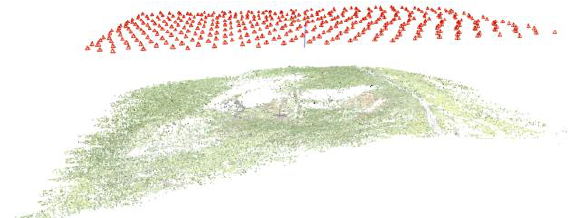
Figure 8. Sparse cloud calculated with COLMAP and Key.Net local